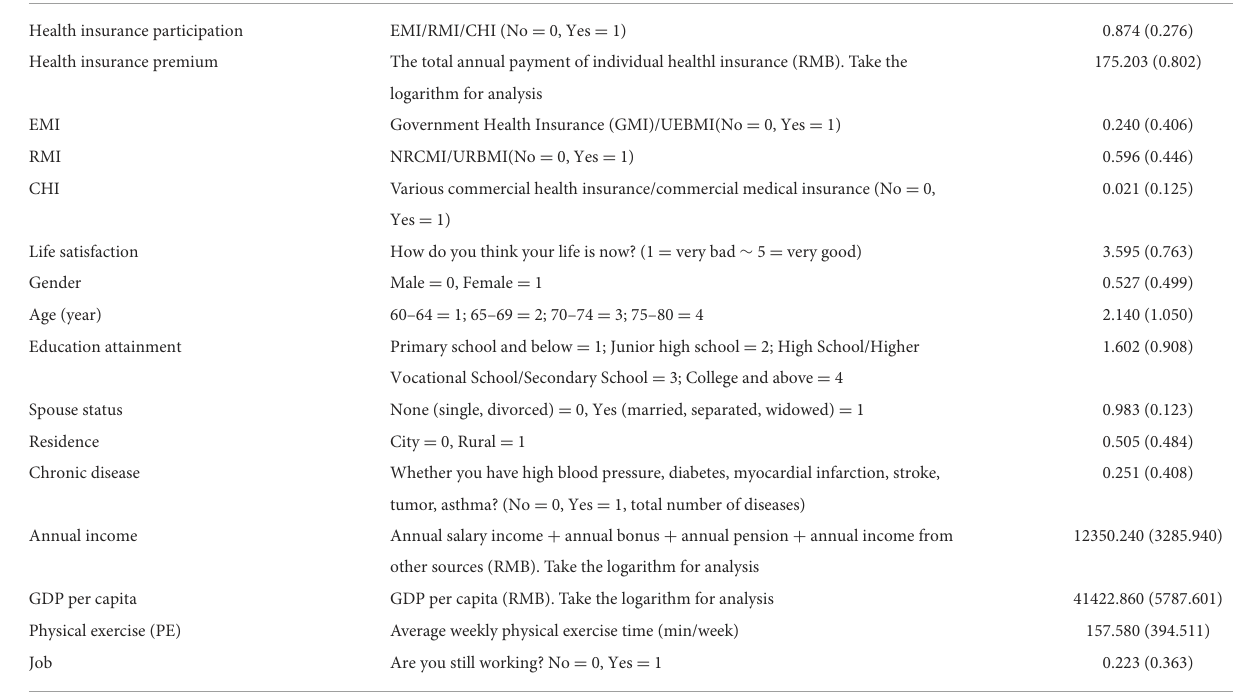
TABLE 1 Descriptive statistics for variables ( n =